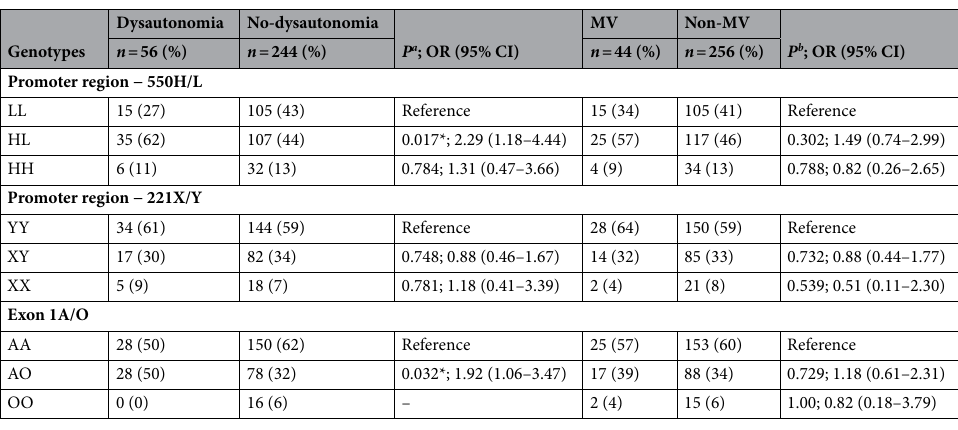
Table 4. MBL2 gene polymorphism association with autonomic dysfunction and mechanical ventilation in GBS. P a -value probability value of dysautonomia vs. no-dysautonomia, OR odds ratio, 95% CI 95% confidence interval, MV required mechanical ventilation, Non-MV not required mechanical ventilation. P b -value probability value of MV vs.